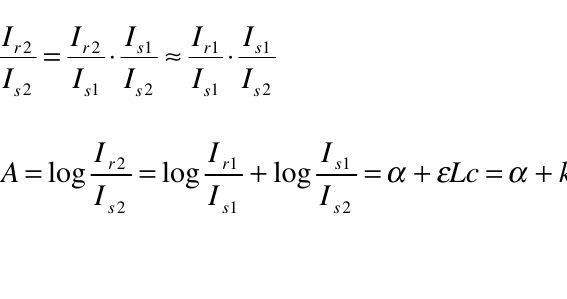
I and I respectively ) transmit out of the fiber-optic bundle 1 s 1 r